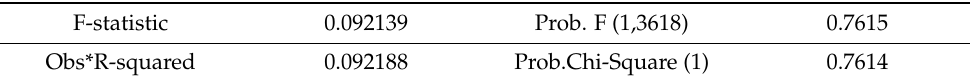
Table 8. ARCH_LM test of Heteroskedasticity GARCH